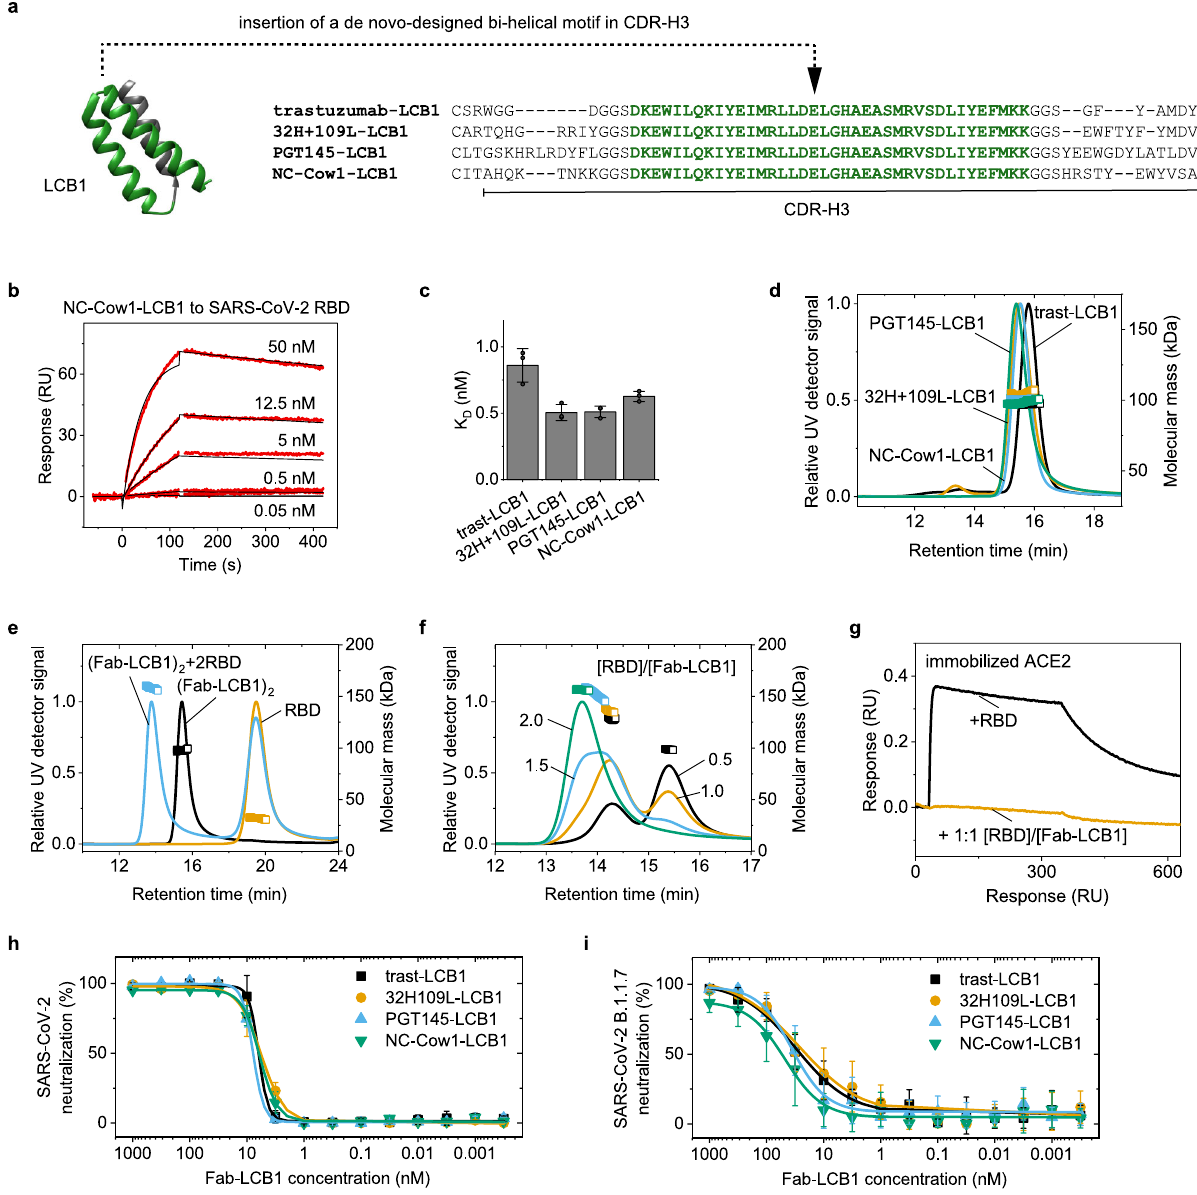
Fig. 4 Grafting of de novo designed mini-domains against SARS-CoV-2 into CDR-H3 of bovine and human Fab fragments. a Structure of tri-helical LCB1 peptide (PDB: 7JZU) discovered by de novo design. The two helices (green) that bind to SARS-CoV-2 spike were inserted in the CDR-H3s of bovine and human antibodies. b Binding of NC-Cow1 with LCB1 insertion to the SARS-CoV-2 RBD in SPR. c Af fi nity constants of the four Fab-LCB1 proteins to SARS- CoV-2 RBD measured with SPR. Mean values of triplicates with standard deviations. d The Fab-LCB1s form dimers with a molecular mass around 100 kDa showing that the bi-helical insertion from LCB1 is not only an antigen-binding site but also a dimerization motif. e SEC MALS shows that the NC-Cow1-LCB1 bound two RBDs, when the RBD is in 5x molar excess. The NC-Cow1-LCB1 alone is in black, the RBD alone in yellow, the mixture of both is in blue. f Substoichiometric concentrations of the RBD lead to the formation of complexes with NC-Cow1-LCB1 that contain one or two RBDs. The following RBD/ NC-Cow1-LCB1 ratios are depicted – 0.5 (black), 1.0 (yellow), 1.5 (blue), 2.0 (green). g The SARS-CoV-2 RBD cannot bind to immobilized ACE2 receptor when the RBD is premixed 1:1 with NC-Cow1-LCB1. h Neutralization of infectious SARS-CoV-2 by trast-LCB1 (IC50 6.3 nM), 32H + 109L-LCB1